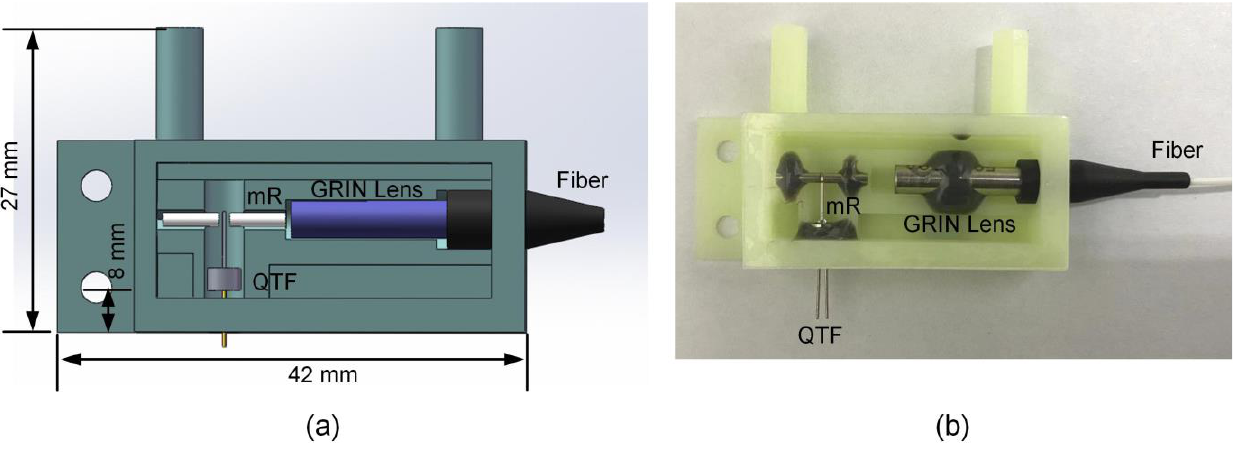
Figure 4. Schematic diagram of 3D-printed ADU: ( a ) design pattern; ( b ) assembled